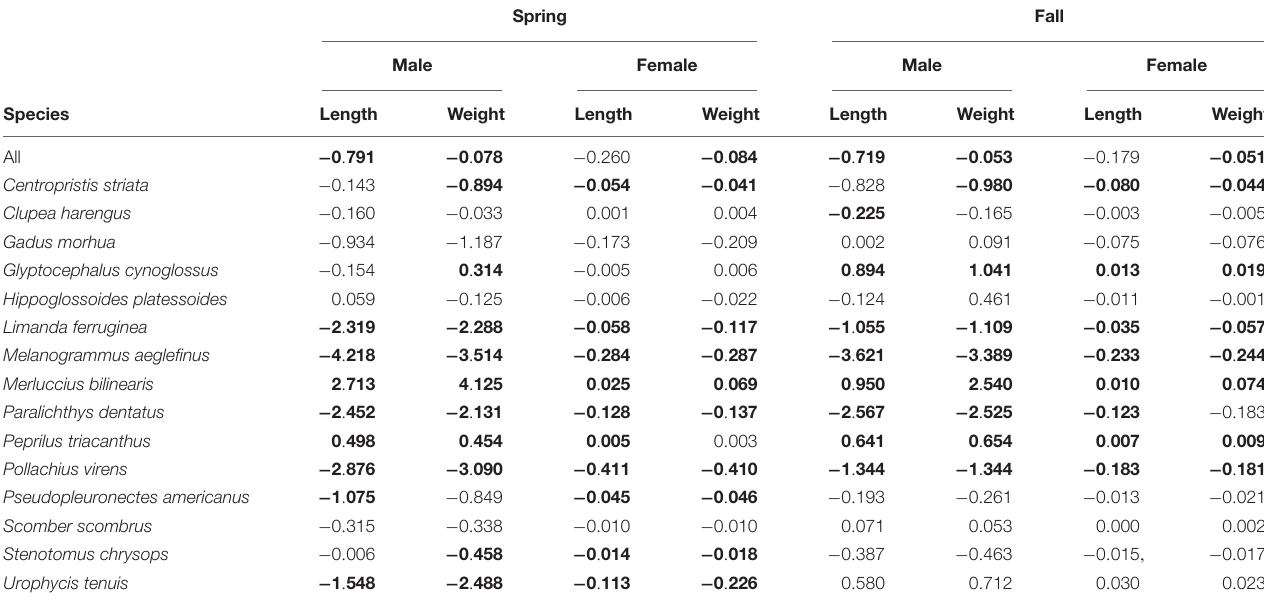
TABLE 2 | Theil–Sen slope estimates expressed in decadal rates of change for growth variables by season and sex for the results of GLM models and by species. Spring Fall